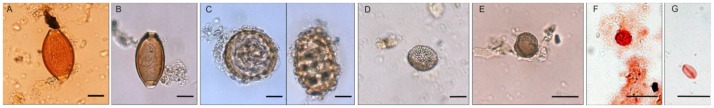
Microscopic observation of unstained and stained Namur coprolite (optical magnification: 100×).A) Trichuris spp. egg (ø 25.83 µm; length 43.65 µm); B) Trichuris spp. egg (ø 22.50 µm; length 41.10 µm); C) Ascaris spp. fertilized egg (ø 49.92 µm) and unfertilized egg (ø 43.16 µm; length 59.92 µm); D) pollen (ø 18.26 µm); E) suspected Taenia spp. egg (ø 14.65 µm); F) suspected Acanthamoeba spp. cyst; and G) seed remains. (The scale bar on the right indicates 20 µm).